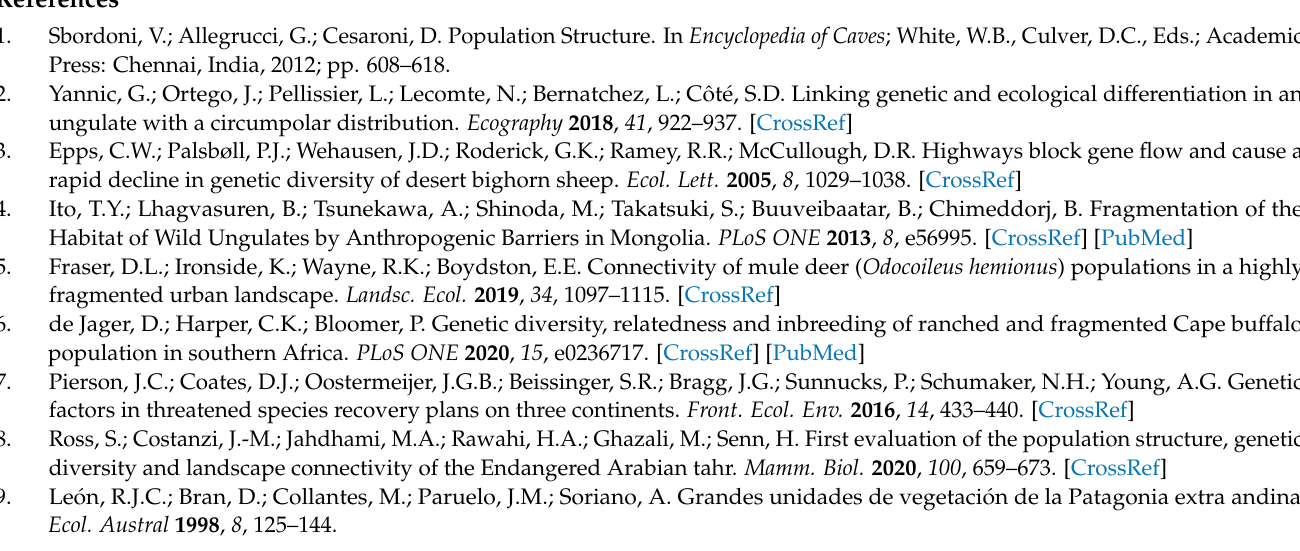
truncated at zero, following Storz and Beaumont (2002); the values on the table correspond to the priors of each of the parameters; LB = low boundary (mean − SD), HB = high boundary (mean + SD); the hyperprior mean of means and variance of means had the same values as the mean and range in the prior, respectively, and the mean of variances and variance of variances were left as default. Figure S1: Relative support for the number of guanaco populations based on the microsatellite data set; D K (Delta K = mean (|L”(K)|)/SD(L(K))), following Evanno et al. (2005) as a function of K, Figure S2: Structure analysis results of 102 Lama guanicoe guanacos from seven localities in Chubut and Rio Negro Provinces in the Patagonia of Argentina based on five repetitions of K1 through K10, with 1,000,000 repetitions and a burn-in of 20,000 and a model assuming a correlation between admixture and allele frequency; localities’ names are LB = Loma Blanca; MS = Meseta Somuncura; TE = Telsen; PV = Pen í nsula Vald é s; BD = Bajada del Diablo; LP = Las Plumas; AM = Ameghino, Figure S3: Plot of the pairwise differences showing the comparison between locality groups; the plot includes the average number of pairwise differences between populations (green), the average number of pairwise differences within populations (orange), and the corrected average pairwise difference (blue). Localities’ names are LB = Loma Blanca; MS = Meseta Somuncura; TE = Telsen; PV = Pen í nsula Vald é s; BD = Bajada del Diablo; LP = Las Plumas; AM = Ameghino, Figure S4: Mantel test graphic showing the results of the isolation by distance (IBD) analysis in ALLELES IN SPACE (Miller, 2005); r = 0.231, p < 0.0009. Figure S5: Demographic analysis of guanaco populations using MsVar demographic models, assuming population expansion, no demographic change, and a bottleneck; (A) depicts the posterior distributions of the present effective-population size (N0) and the ancestral effective-population size (Nt), and (B) shows the estimated time when the demographic event